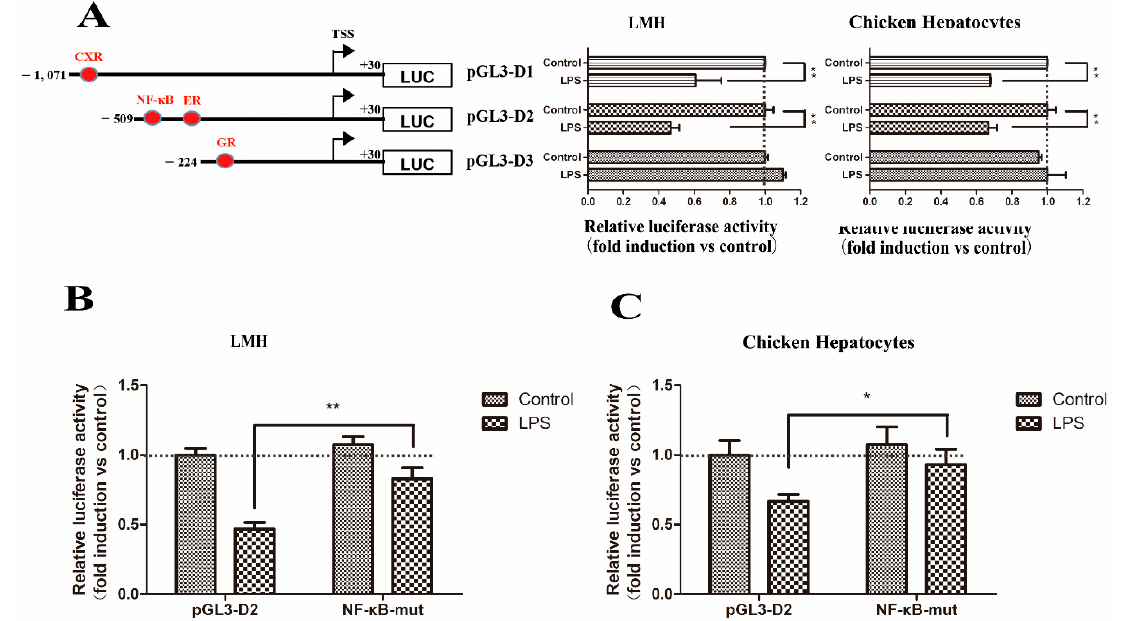
Figure 9. Regulation of chicken Abcg2 promoter activity by lipopolysaccharide (LPS). ( A ) Isolation of the promoter elements responsible for mediating the stimulation of the Abcg2 gene promoter activity by LPS. LMH cells and chicken hepatocytes were transfected with deletion constructs of the Abcg2 promoter. A schematic illustration of the Abcg2 gene promoter reporter plasmids used is shown in the left panel. A point mutation was introduced into the pGL3-D4 construct. ( B ) LMH cells and ( C ) chicken hepatocytes were transfected with each mutant. The fold increase in the luciferase activity by LPS treatment of each construct is indicated. * represents p < 0.05 and ** represents p < 0.01.